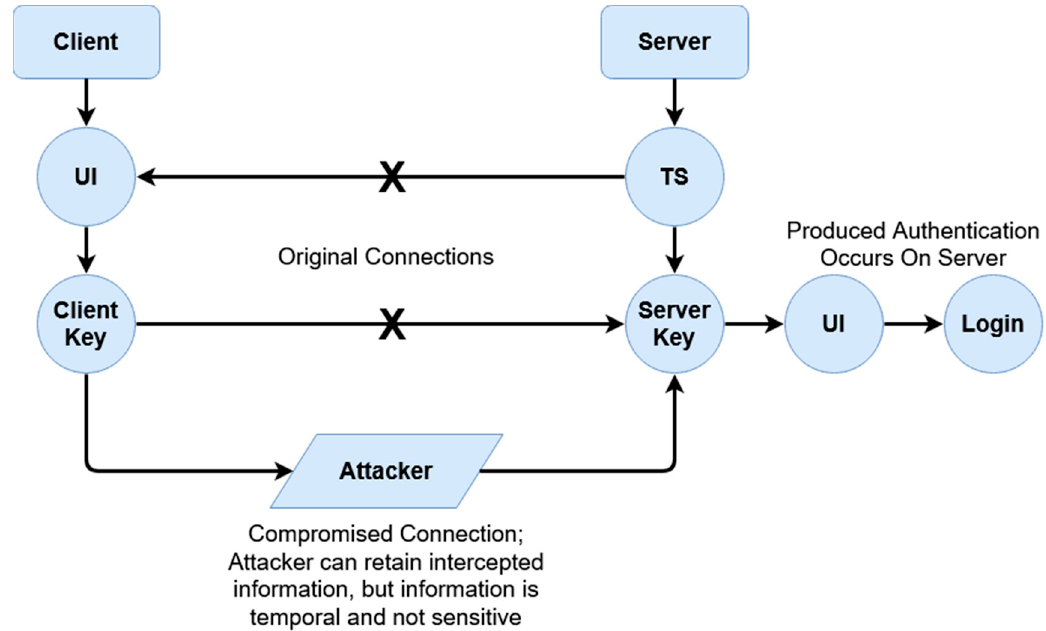
Figure 9. MiTM attack under TFHVA scheme.